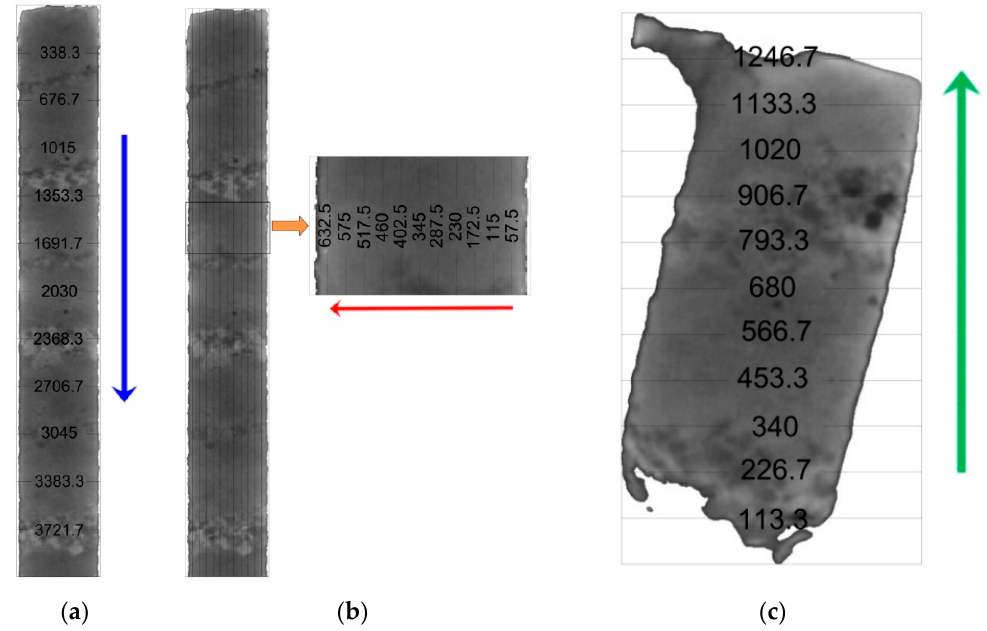
Figure 4. The location of the sections selected for analysis in the scanning directions of the sample (arrows indicate the scanning direction, numbers—the distance from the zero point of the sample (a scan beginning), in µm). ( a ) Vertical scanning; ( b ) frontal scanning; ( c ) profile scanning. The images obtained as a result of scanning are characterized not only by the presence of the black background, but also the so-called “shadow” from the underlaying surfaces of the sample (Figure 5).